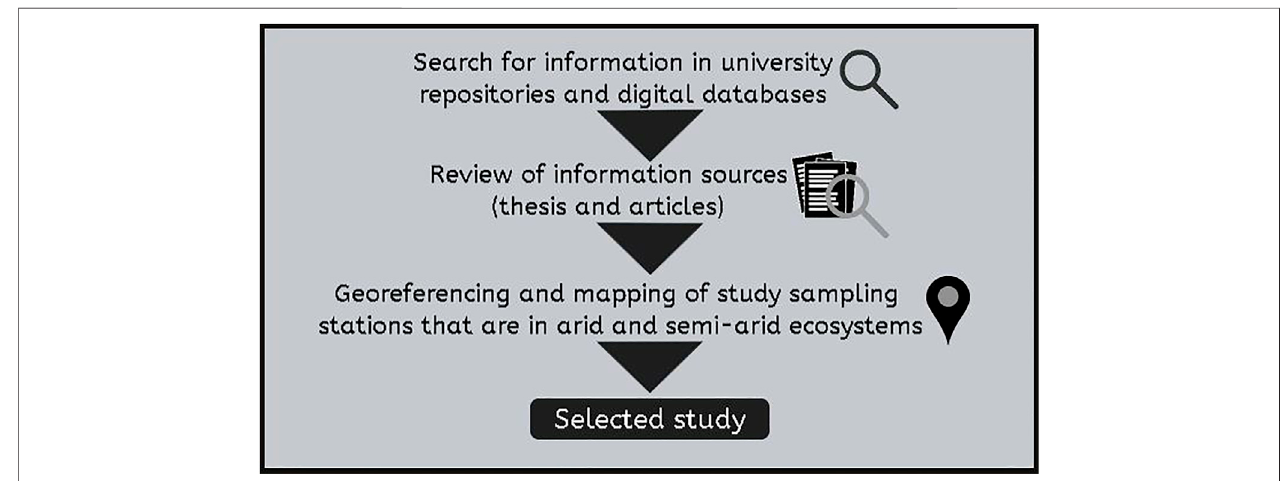
FIGURE 1 | Methodology for the selection of studies on aquatic macroinvertebrates in arid and semi-arid ecosystems of Peru.